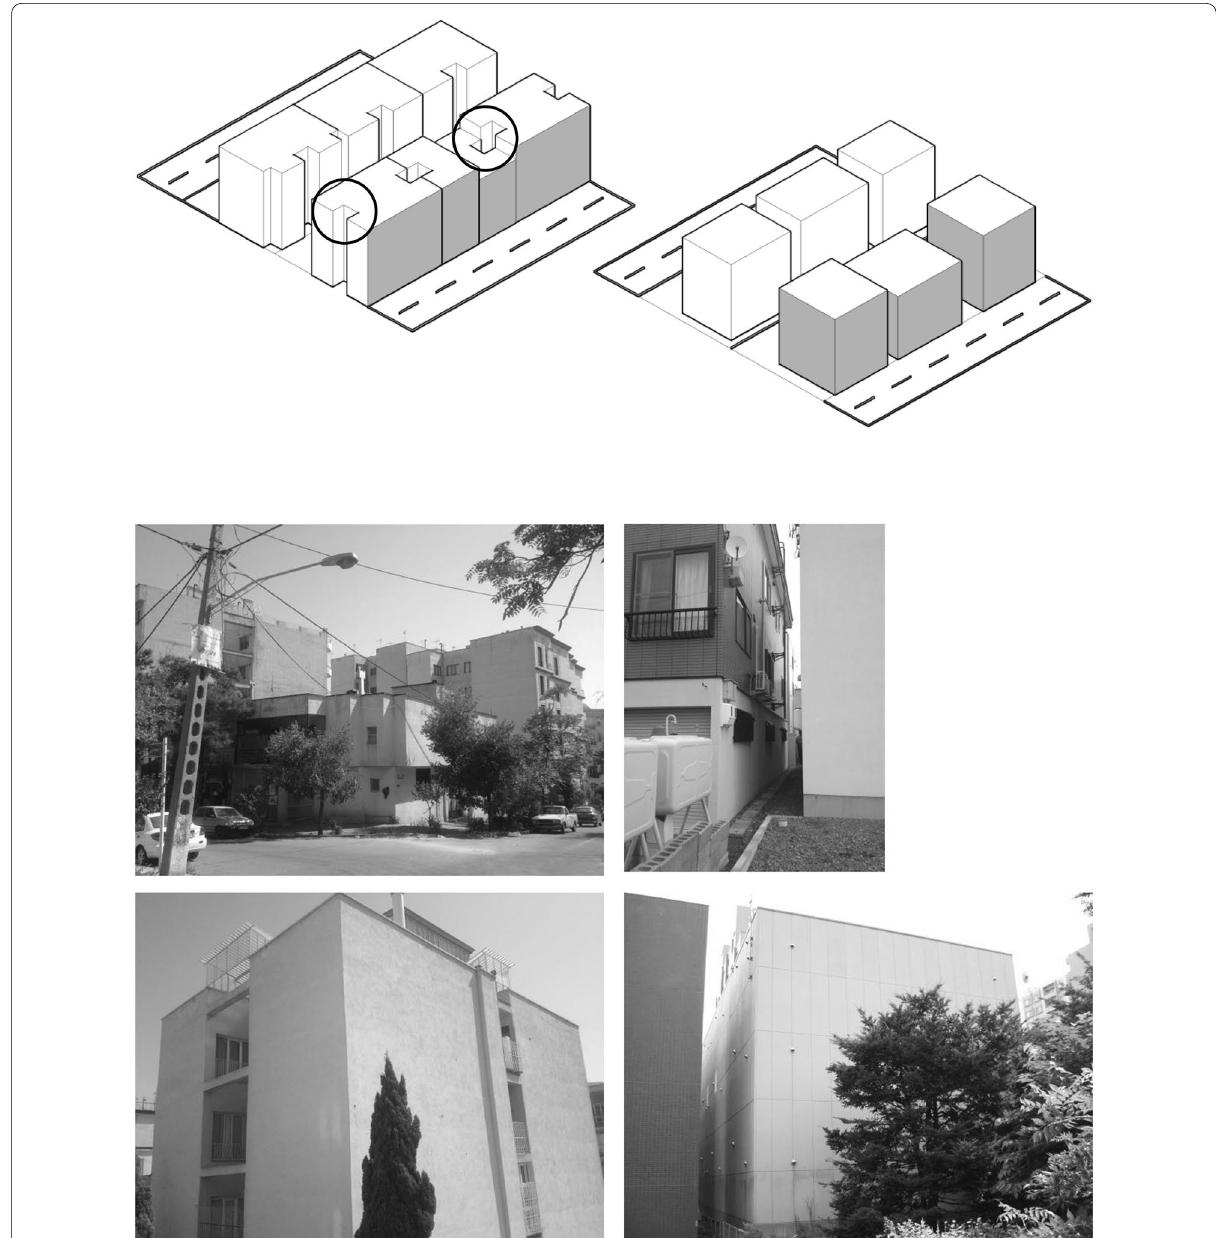
Fig. 2 (Top Left) Inner courtyards as mere light shafts in housing blocks in Iran, whereas in the Japanese case (Top Right) open spaces are shaped as side setbacks. There is a hypothesis that redistributing the open spaces in Iranian case and introduce wider inner courtyards will contribute to the better ventilation and perception of these open spaces in residential blocks (Bottom). Facades with windows are colored in grey. (Left) Hayat-khalvats as light shafts in housing blocks in Shiraz. (Right). Side setbacks in Sapporo